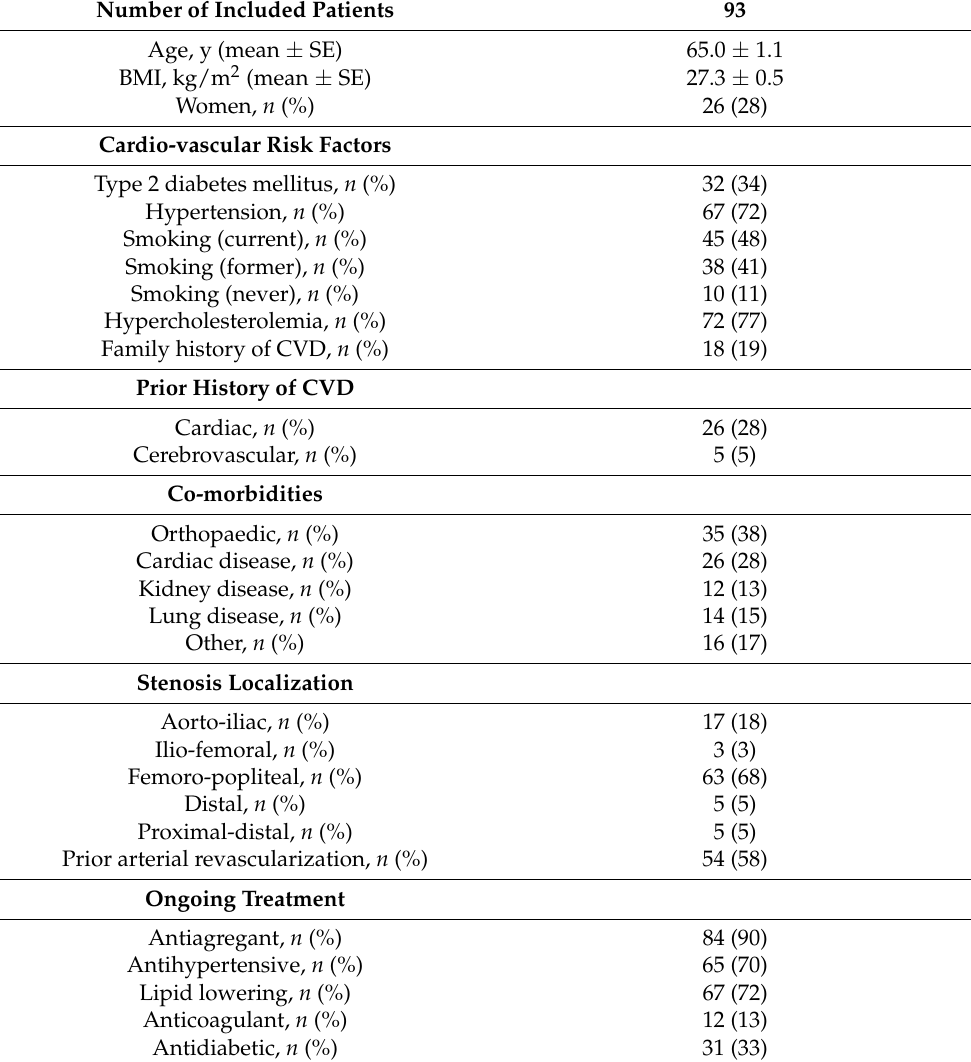
Table 1. Characteristics of